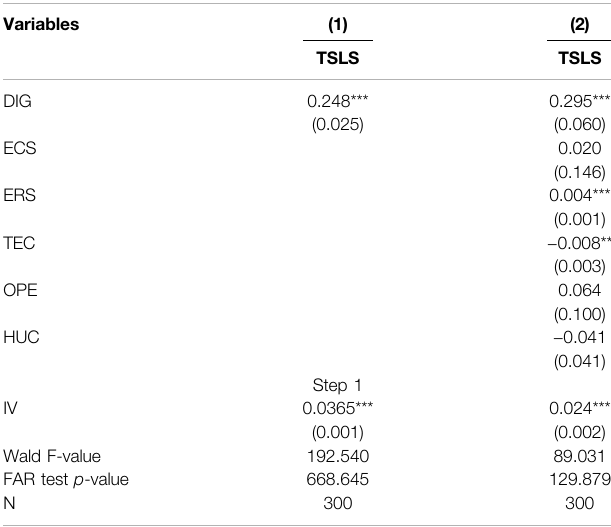
TABLE 5 | Endogeneity results.